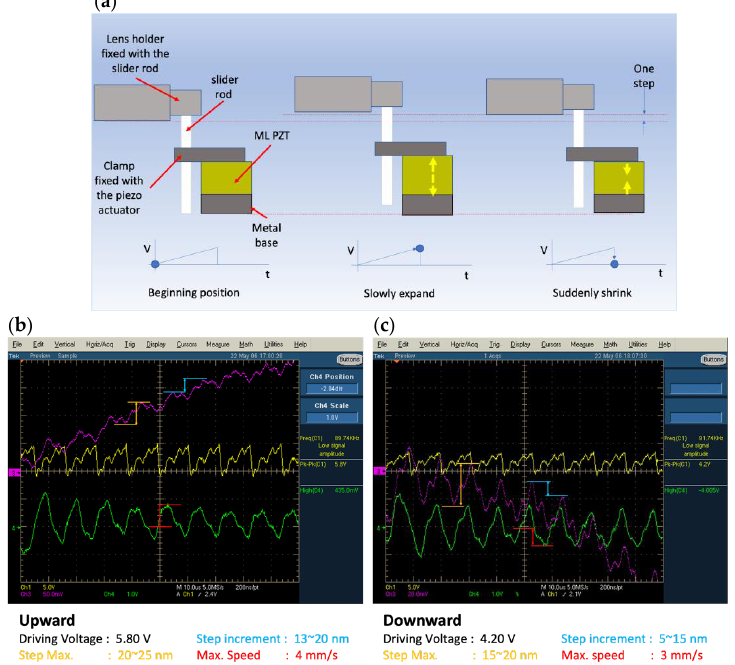
Figure 4. ( a ) SIDM movement of the Lobster USM and Lobster USM moving performance. ( b ) Up- ward movement at a 5.80 V driving voltage. ( c ) Downward movement at a 4.20 V driving voltage.